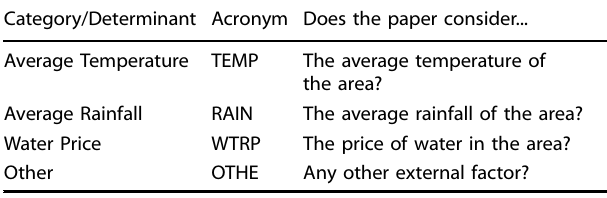
Table 3. Sub-categories/determinants classi fi ed as external. Category/Determinant Acronym Does the paper